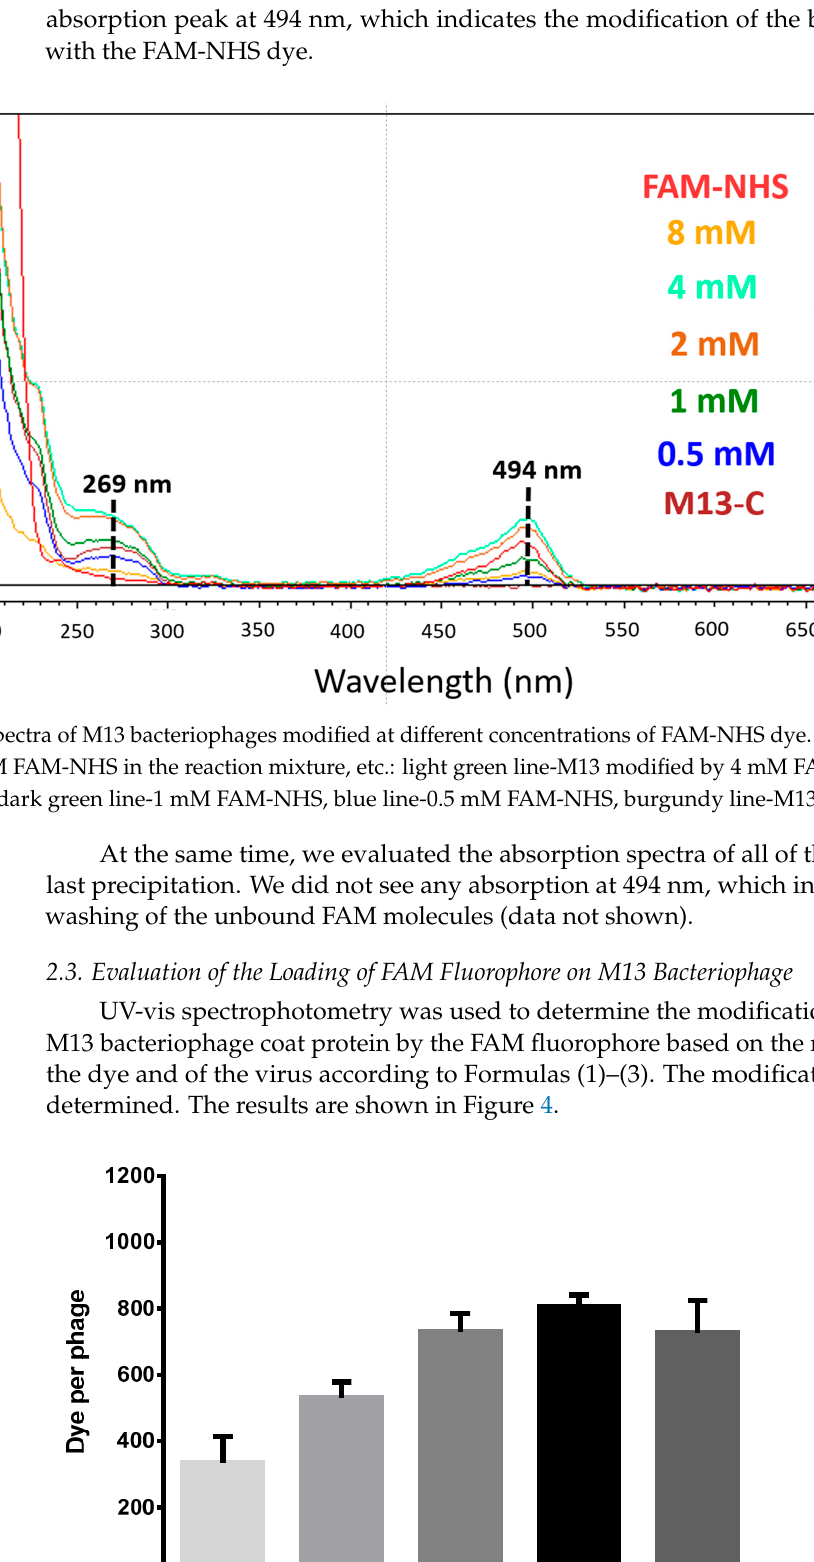
ing agent was at a high concentration (8 mM FAM-NHS), the degree of modification de- creased to 726.2 dye molecules/phage. There is a possibility that is phenomenon is caused by the formation of FAM fluorophore dimers, leading to a change in the optical properties. A similar phenomenon was shown for TAMRA dye by Li K. et al. [18]. 2.4. Analysis of the Binding Efficiency of the Modified Bacteriophage to Tumor Cells The analysis of the binding efficiency of the modified bacteriophage to tumor cells MDA-MB 231 was performed using flow cytometry (Figure 5). The proportion of stained cells increased with increasing fluorophore concentration, with the maximum being ob- served for the sample “4 mM Fam-NHS + phages” (98.4%); it is worth noting that the histogram corresponding the sample “4 mM Fam-NHS + phages” was higher and nar- rower than that for the sample “8 mM Fam-NHS + phages”, which could point to the more specific binding of these phages to the tumor cells MDA-MB 231. Figure 5. The flow cytometry of the tumor cell MDA-MB 231, which was incubated with M13-FAM phages. Notes: purple—control phage cells incubated with unmodified phages; pink—control cells